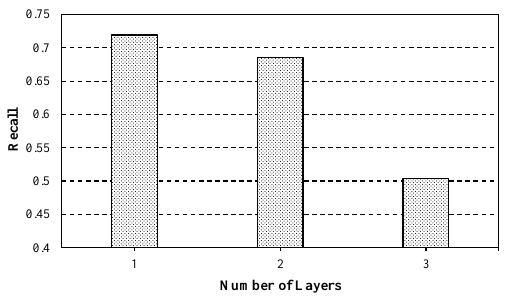
Figure 6. Recall of CARE-GNN with different number of